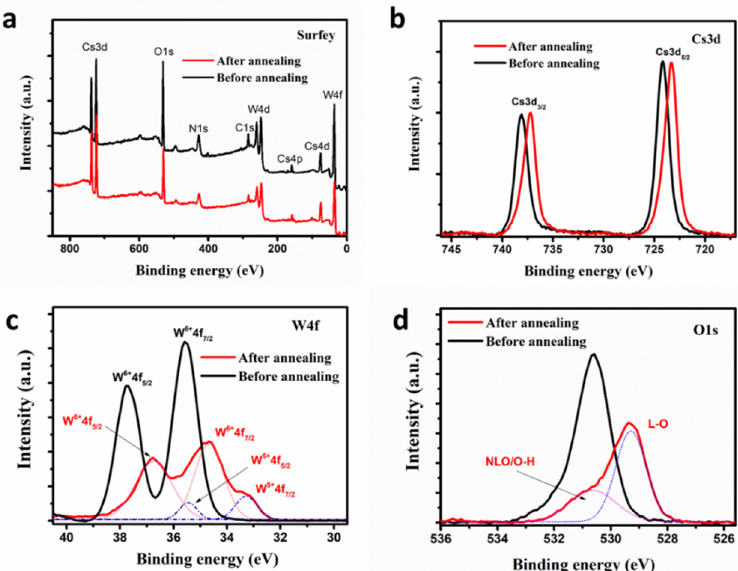
Figure 4. XPS analysis of Cs 0.33 WO 3 nanocrystals synthesized via mist-CVD: ( a ) The survey scan and the core-level spectra of ( b ) Cs3d, ( c ) W4f, and ( d ) O1s before and after annealing.